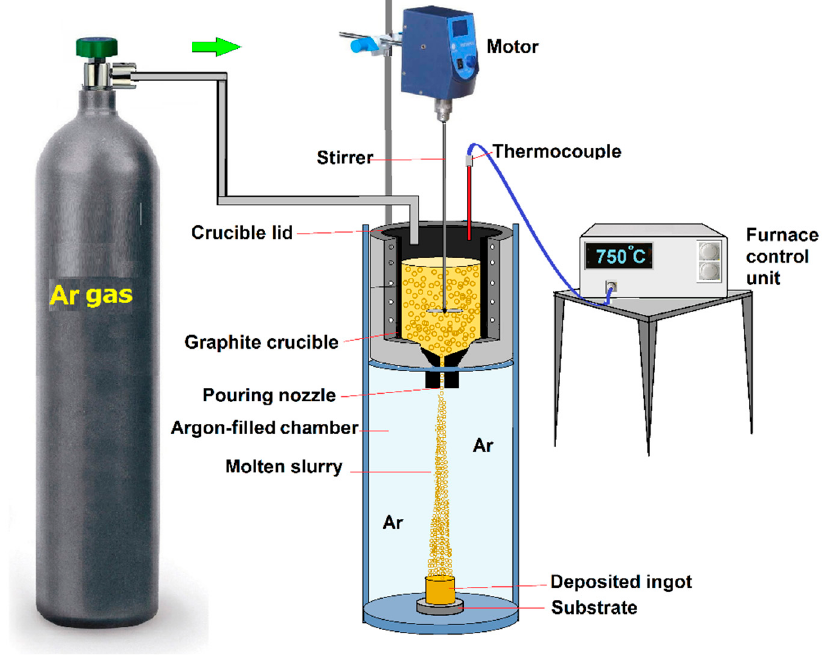
Figure 7. Schematic representation of the disintegrated melt deposition (DMD) process reproduced from [27], with permission from Elsevier, 2013.